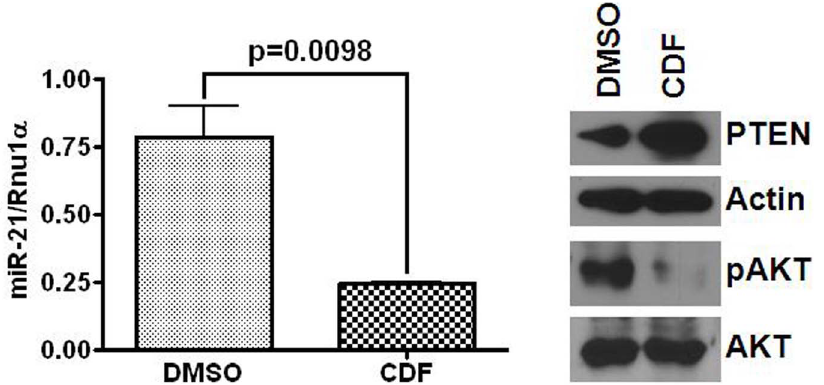
Figure 4. Quantitative real-time RT-PCR ( left panel ) showing downregulation of miR-21 in response to CDF for 72 h in SW620, a metastatic colon cancer cell line; while control was incubated with an equivalent volume of DMSO. Western-blots ( right panel ) showing changes in relative expression of PTEN, pAkT and total Akt in SW620 cells following 72 h incubation with CDF or DMSO (controls). Human b - actin served as the loading